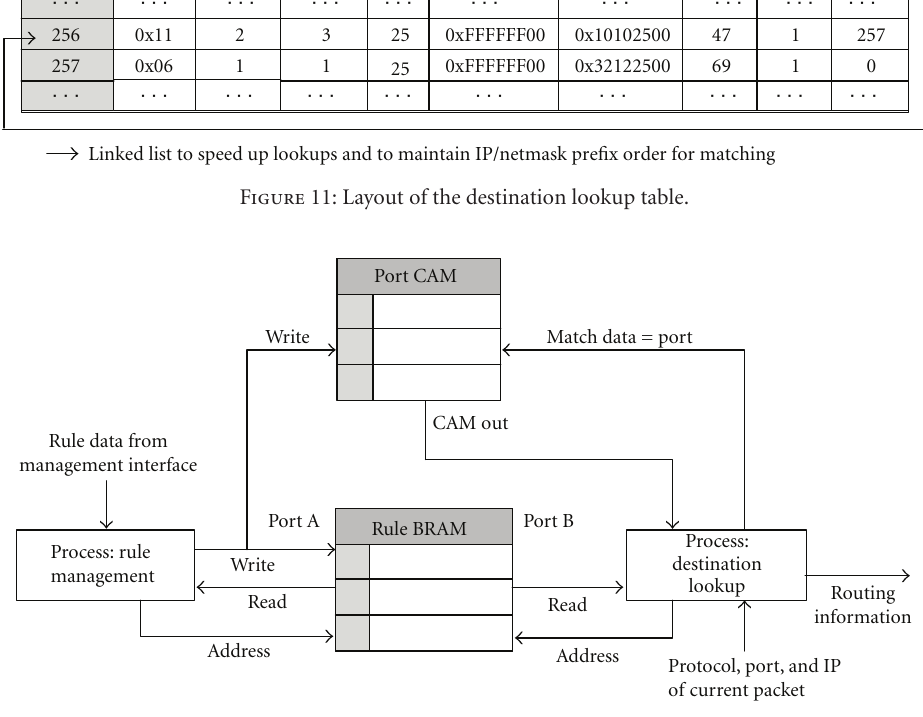
Figure 12: Implementation of the destination lookup